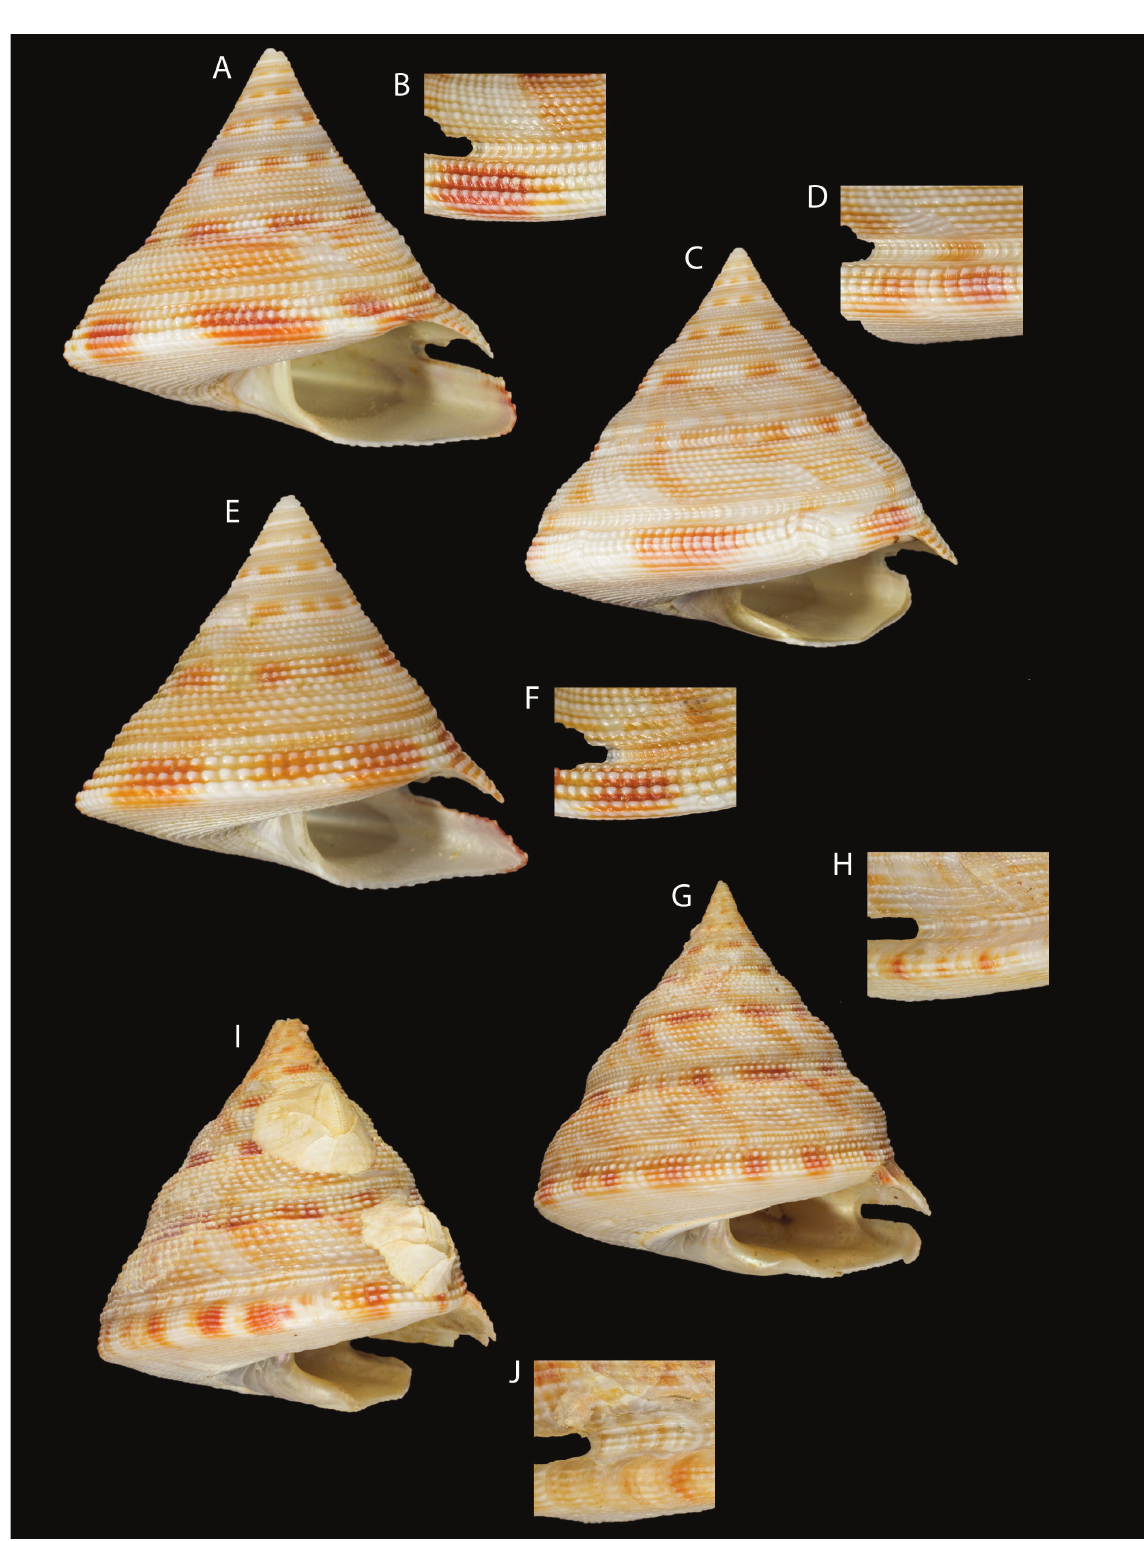
Fig. 4. Perotrochus wareni sp. nov., paratypes. A–B . Mnhn-iM-2007-34680 (h = 28.2